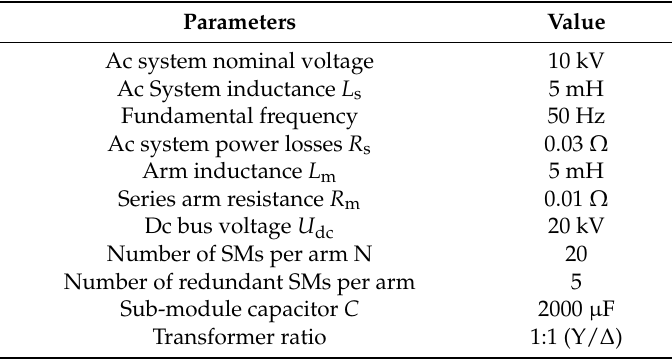
Table 1. Main parameters of the simulation